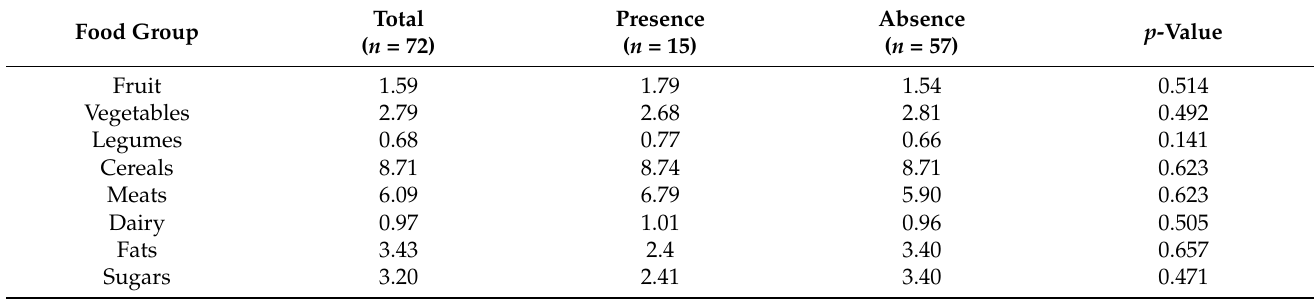
Table A2. Food consumption in the presence of cardiovascular risk (W-H.I).